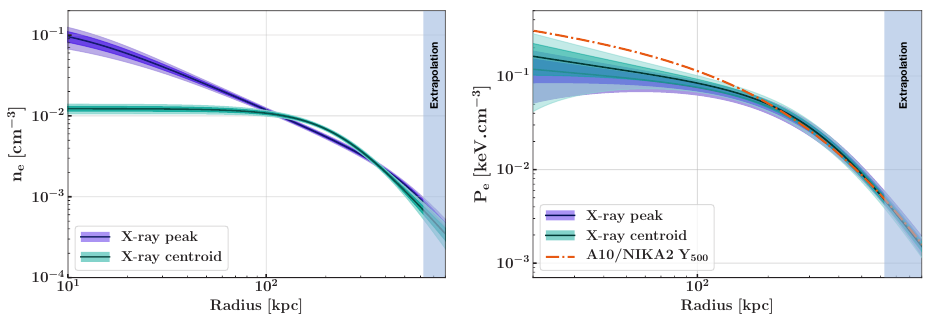
Figure 2. Density (left) and pressure (right) profiles of MOOJ1142 + 1527 estimated by considering the X-ray peak (purple) or the X-ray centroid (green) in the deprojection procedure based on the Chandra and NIKA2 data. The dark and light colored regions around the best-fit profiles give the 68% and 95% confidence levels. The light grey rectangles show the region where the models are extrapolated but not constrained by the data. Figure extracted from